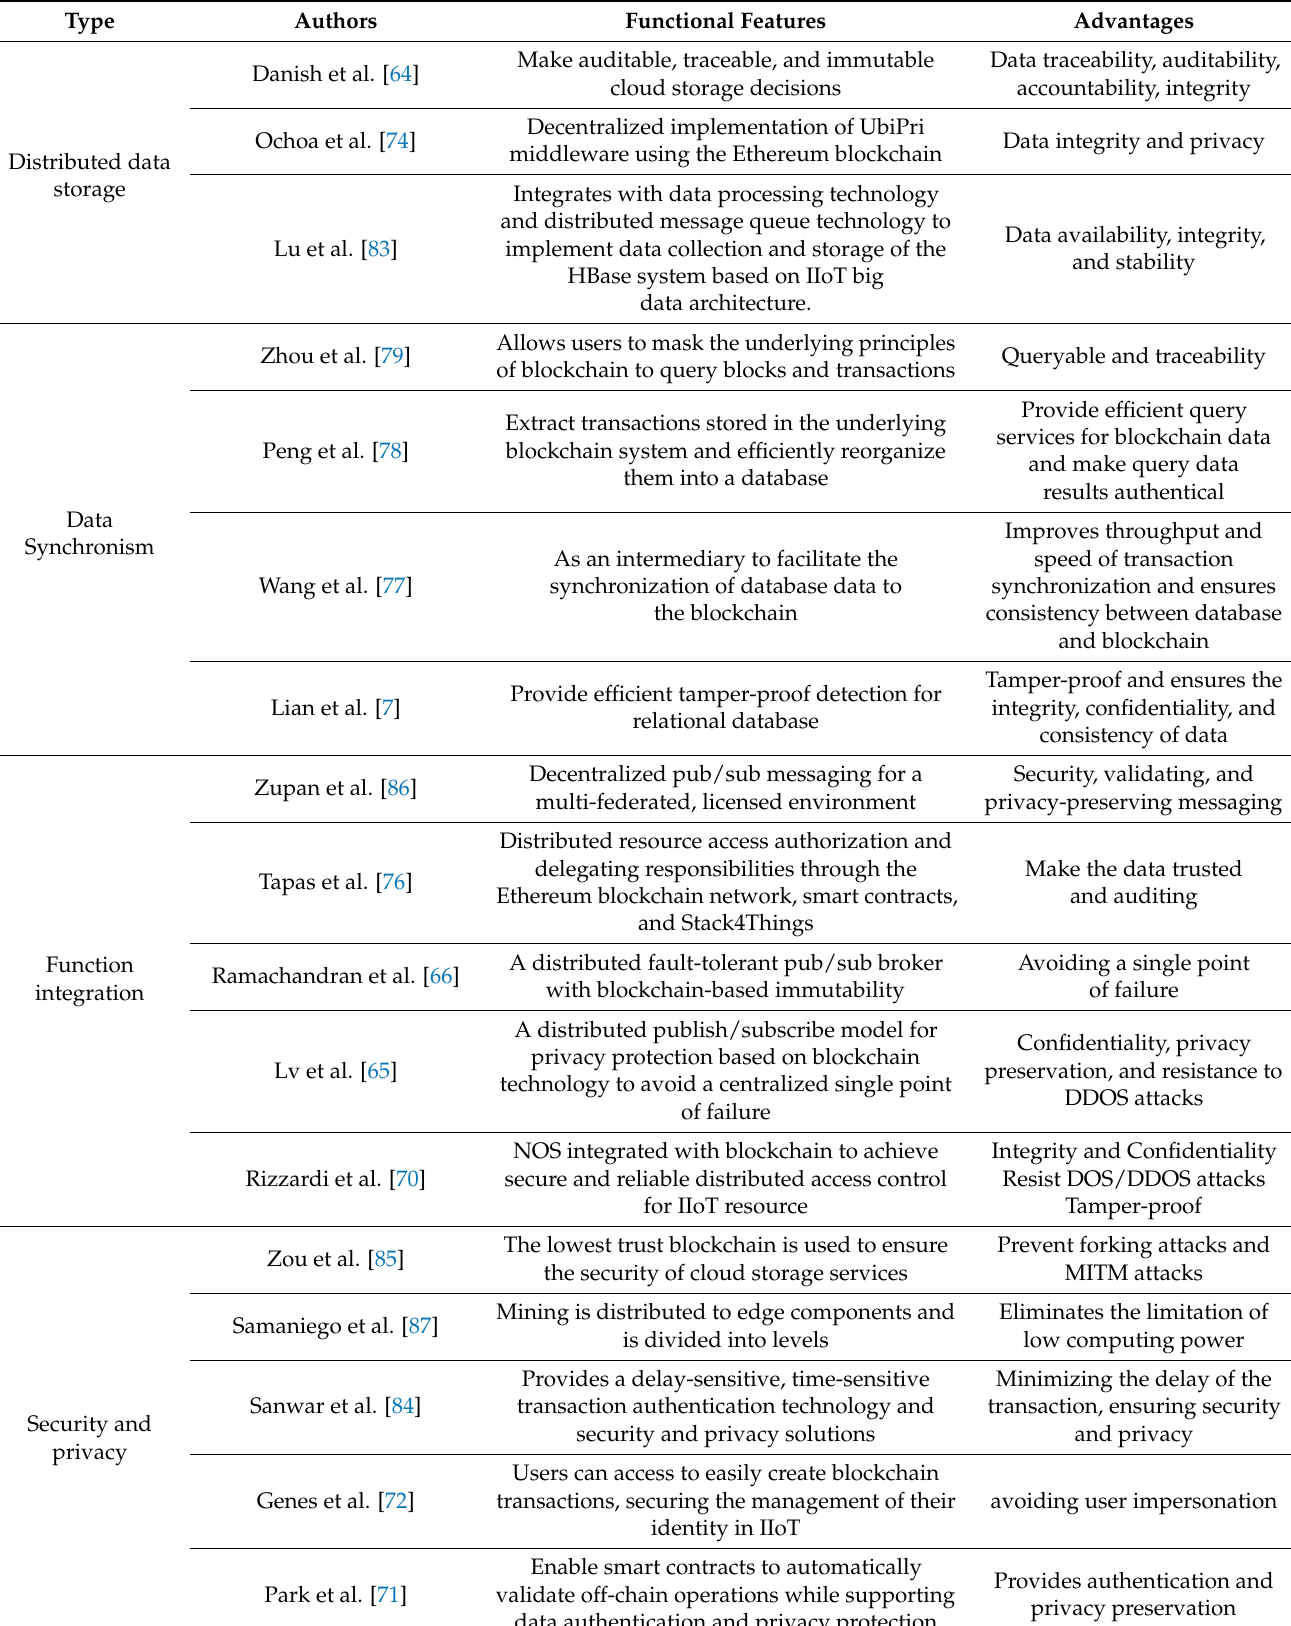
Table 4. Review of blockchain middleware in recent